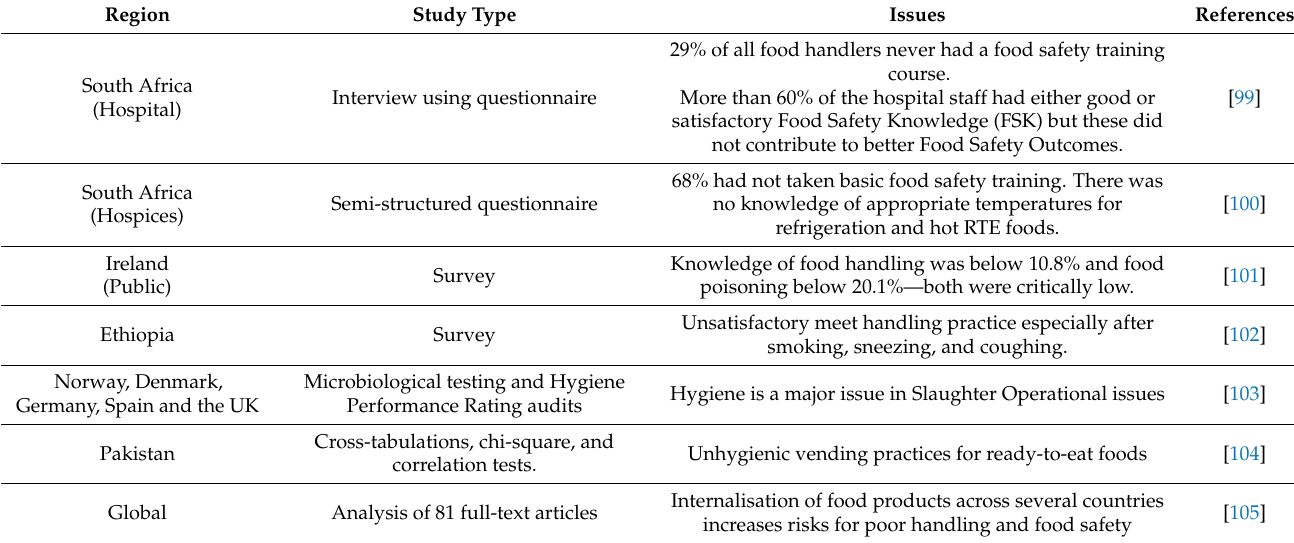
Table 8. Report on food handling